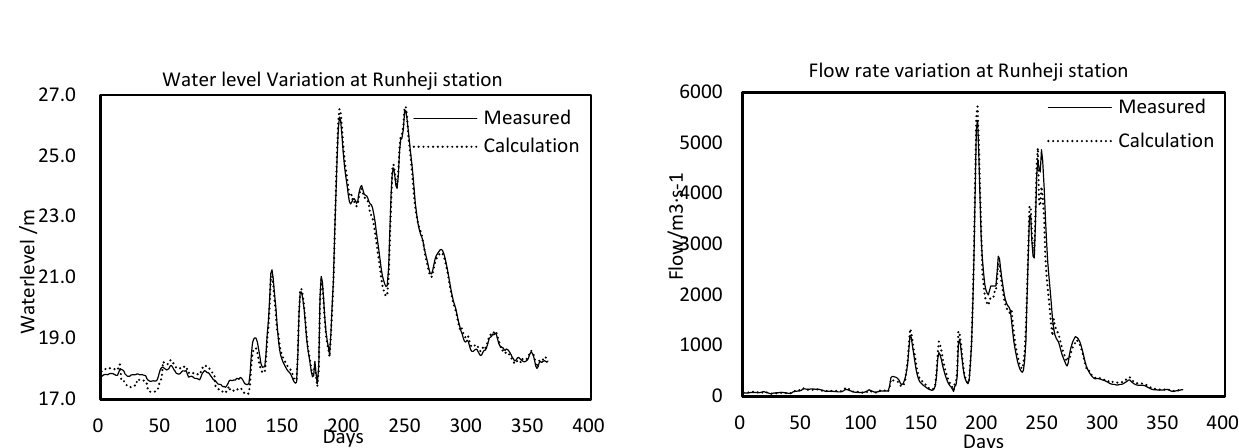
Table 3. Statistics of hydro-sediment volume in the river under different flow–sediment scenarios.